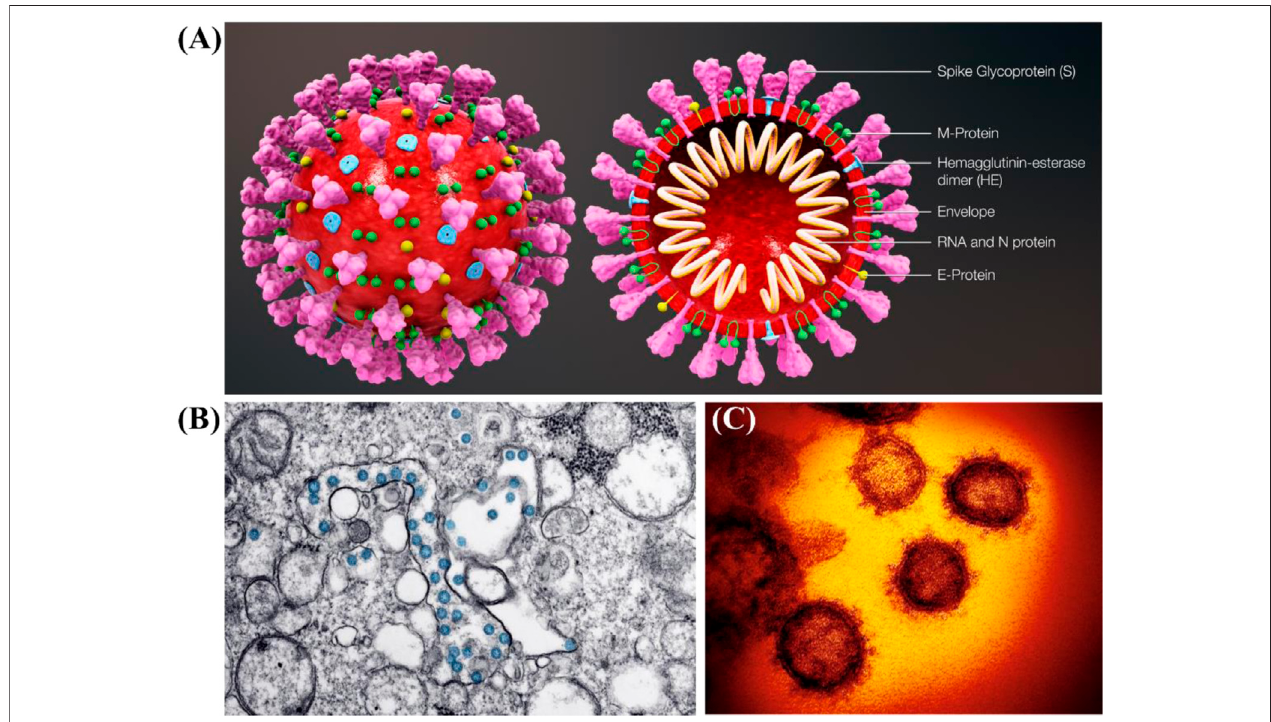
FIGURE 1 | (A) Schematic diagram of SARS-CoV-2 and its cross-sectional representation with proteins (Scienti fi c Animations, 2020). (B) Transmission electron microscope image of SARS-CoV-2 (CDC, 2020). (C) False colored images of SARS-CoV-2 (Kostarelos, 2020a).